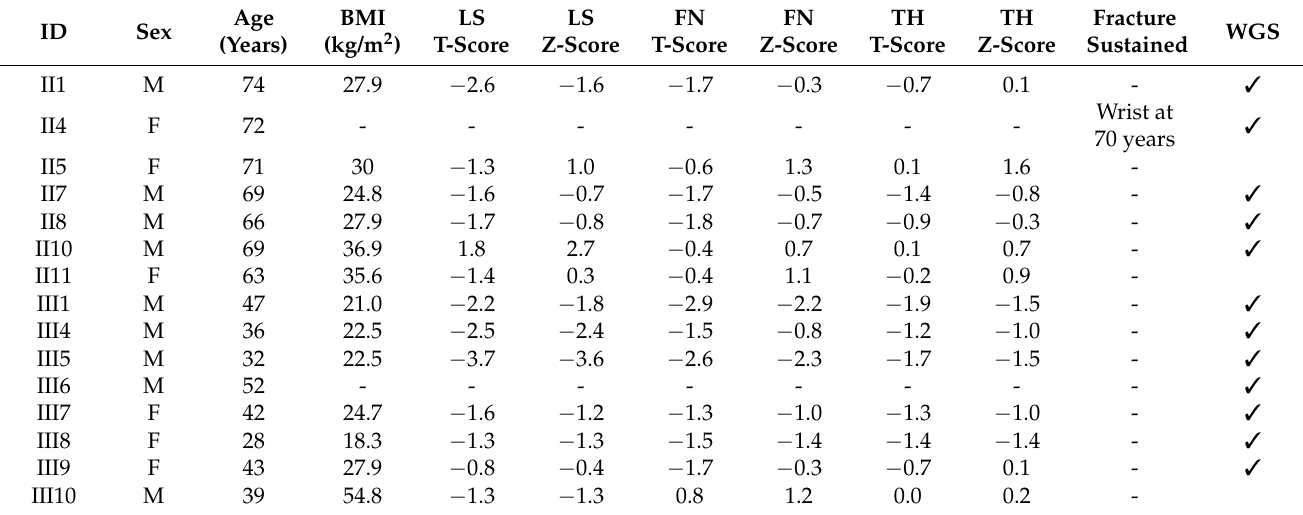
Table 1. Clinical characteristics of the recruited relatives.